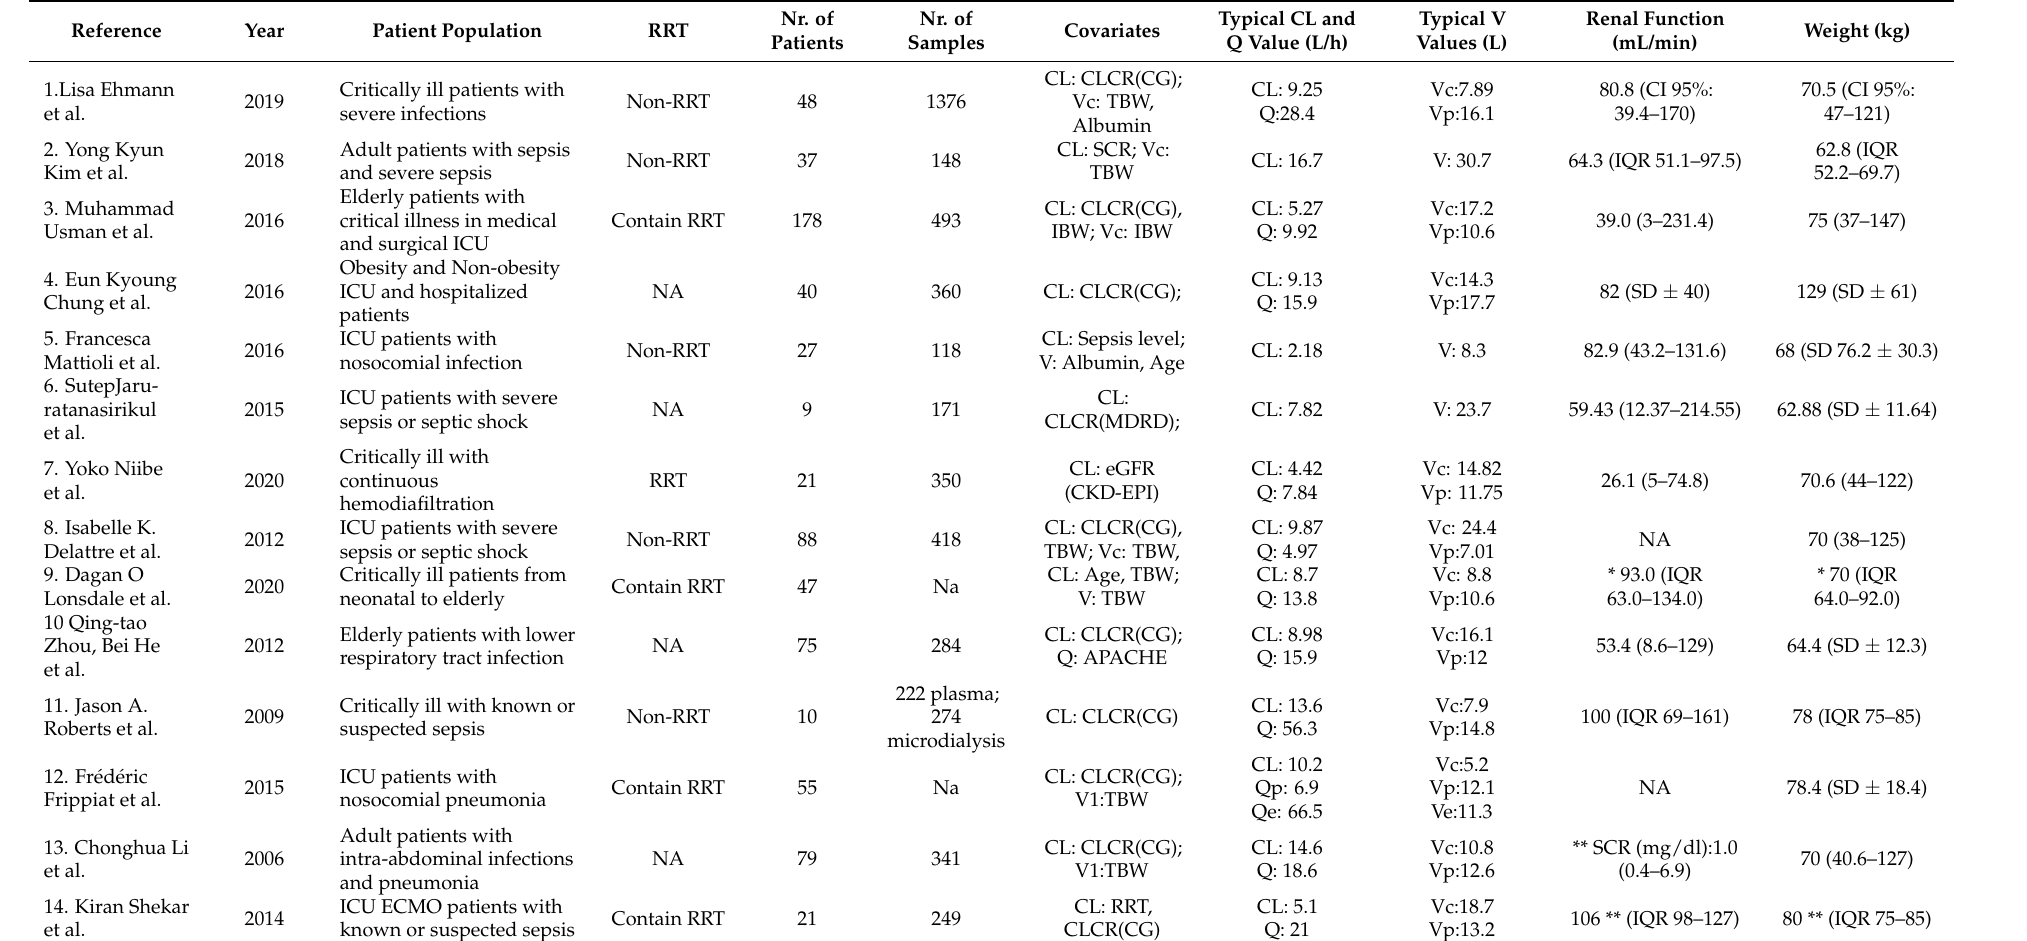
Table 2. Characteristics of included meropenem population pharmacokinetic